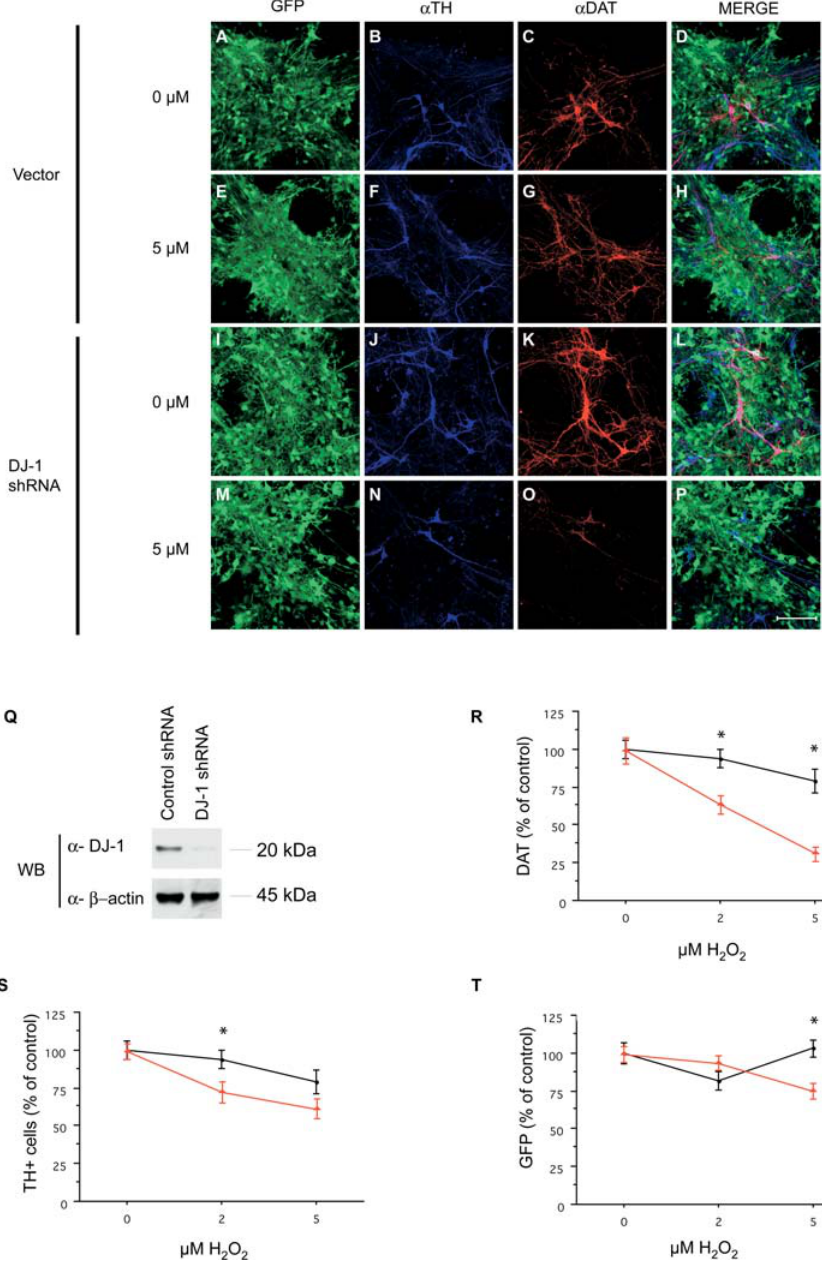
Figure 5. RNAi ‘‘ Knockdown ’’ of DJ-1 in Primary Embryonic Midbrain DNs